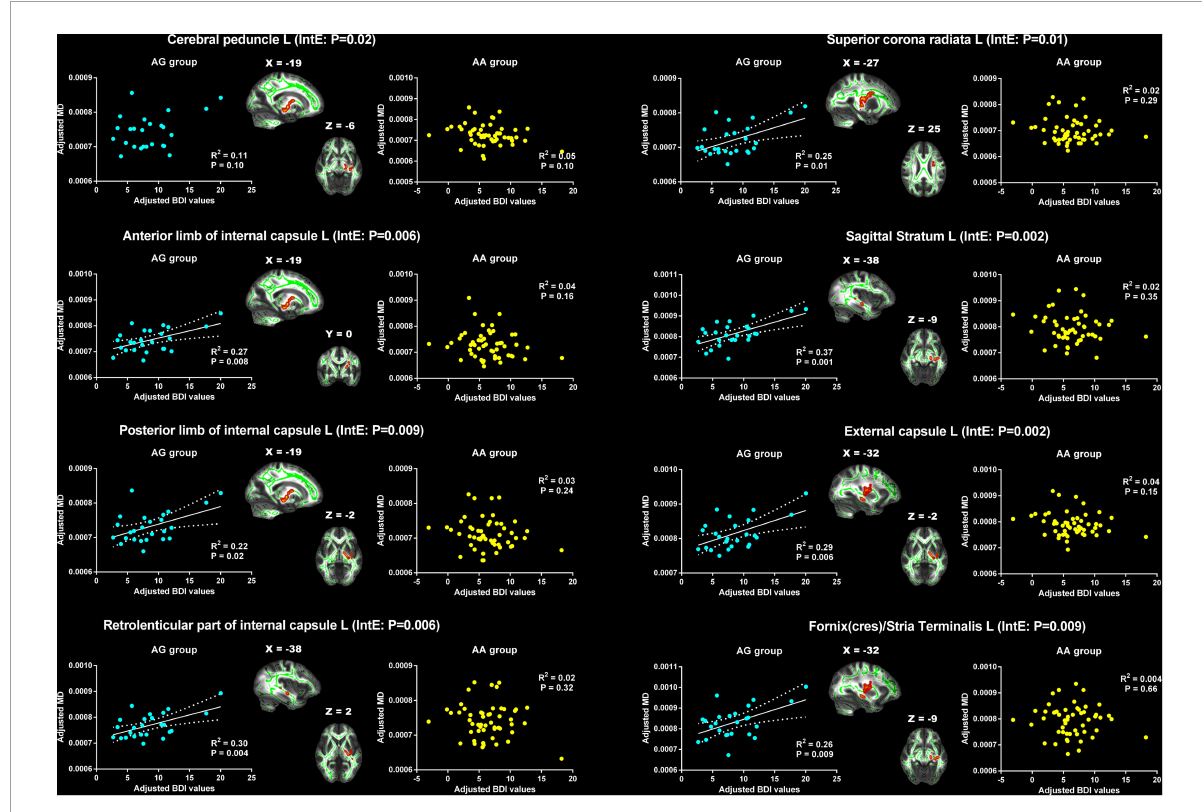
FIGURE4 Significant effects of PER1 genotypes on the associations between BDI values and MD. The significant interaction effects of genotypes × BDI were observed in the white matter tracts of cerebral peduncle, anterior limb, posterior limb and retrolenticular part of internal capsule, superior corona radiata, sagittal stratum, external capsule and fornix/stria terminalis on the left cerebral hemisphere. The adjusted BDI and MD were the measures after removing the ten covariates. For the convenience of showing interaction effect, we averaged the adjusted BDI and MD among the voxels in the above WM tracts, and performed the correlation analysis between the adjusted BDI value and MD of WM tracts in each group. BDI, Beck Depression Inventory; MD, mean diffusivity; L, left. The blue dot represents the AG group; the yellow dot represents the AA group. InE, interaction effects. The white solid line represents the linear regression of the